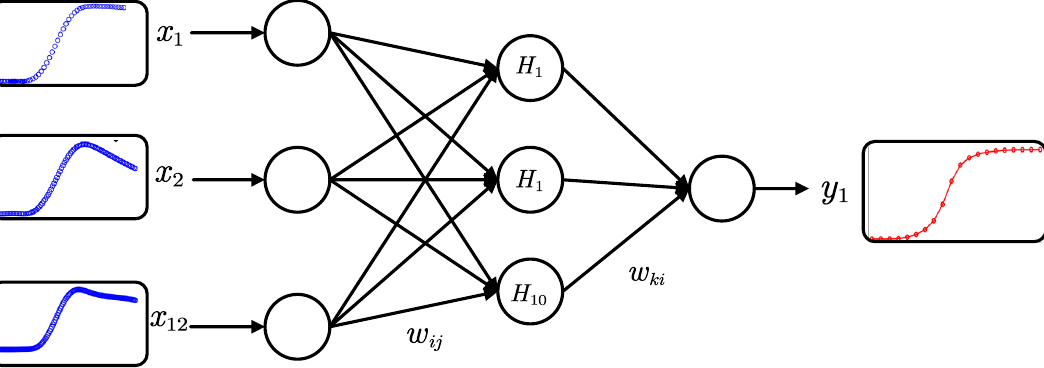
Figure 14. The structure of the BP neural network used in this article.